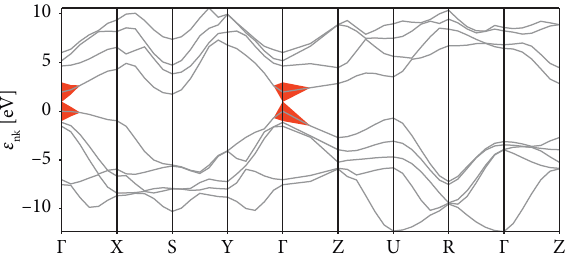
Figure 7: Te contribution of the exciton at the valence band and conduction band edge.